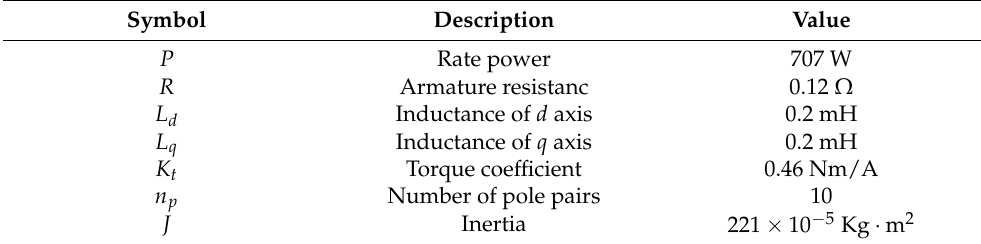
Figure 8. Photograph of the experimental platform. Table 1. PMSM